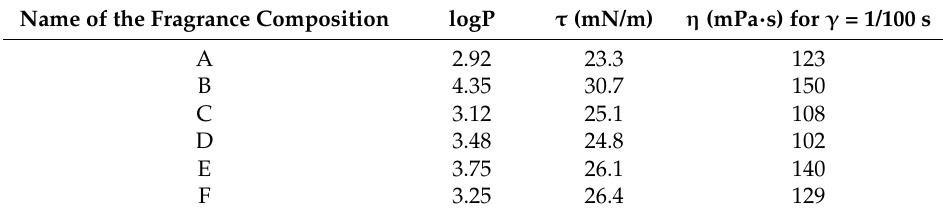
Table 2. Physicochemical properties of fragrance